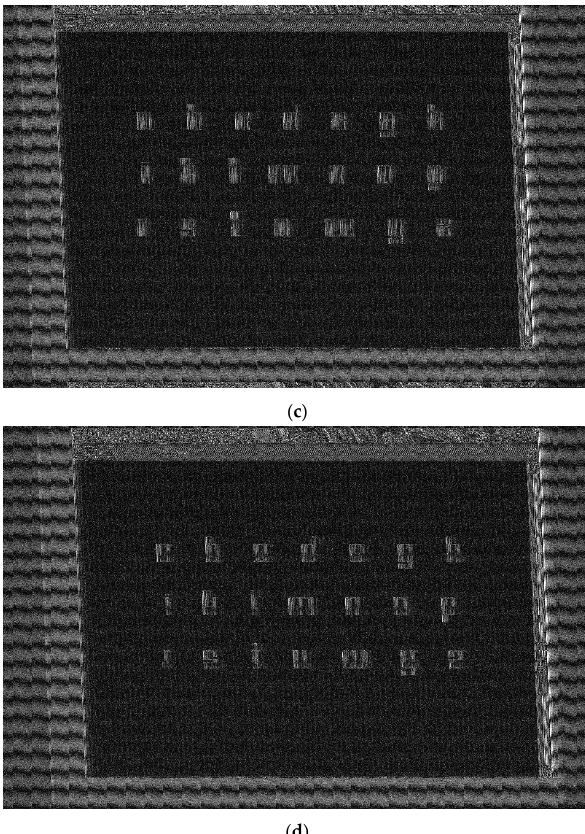
Figure 4. Reconstruction of the displayed image based on sensitive emissions measurement on frequency 840 MHz ( BW = 50 MHz, the size of characters-36 points): ( a ) Arial font, ( b ) Times New Roman font, ( c ) secure asymmetrical font, ( d ) secure symmetrical font.